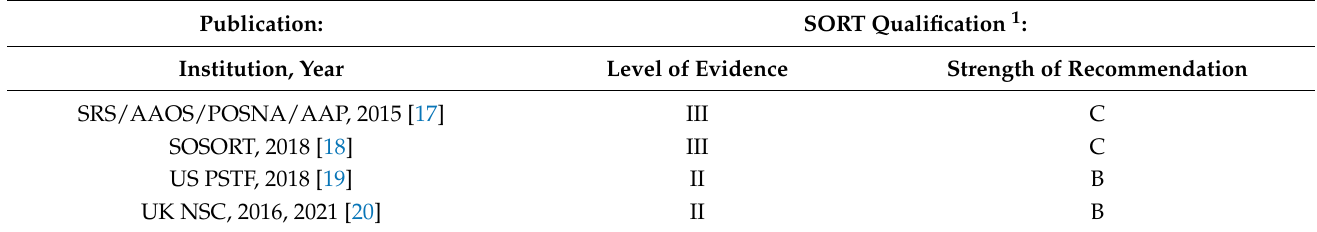
Table 3. The Strength of Recommendation Taxonomy, SORT, qualifications of the levels of evidence, and strengths of recommendations of the included recommendation documents